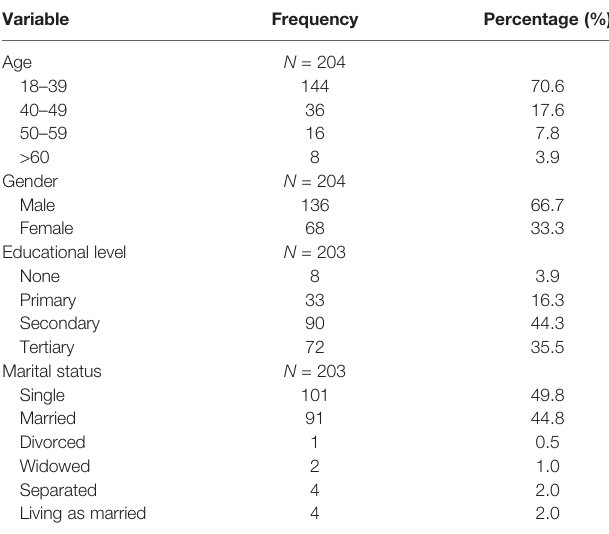
TABLE 1 | Sociodemographic data of the study participants.